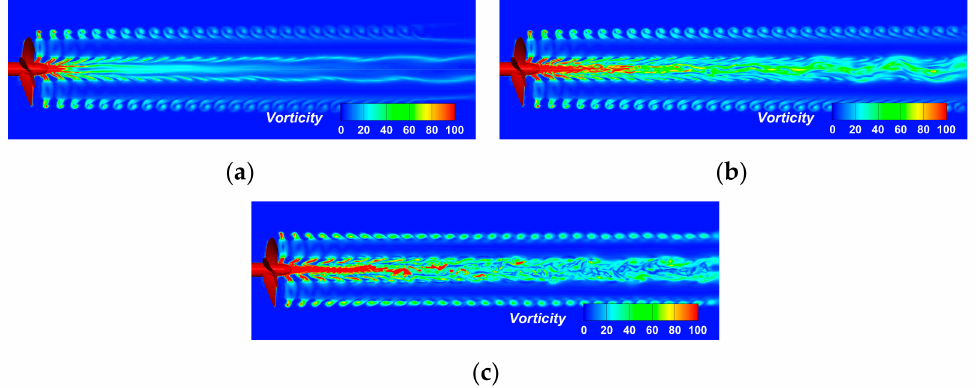
Figure 6. Instantaneous vorticity fields computed on the longitudinal plane of symmetry: ( a ) J = 0.5, ( b ) J = 0.7, ( c ) J =